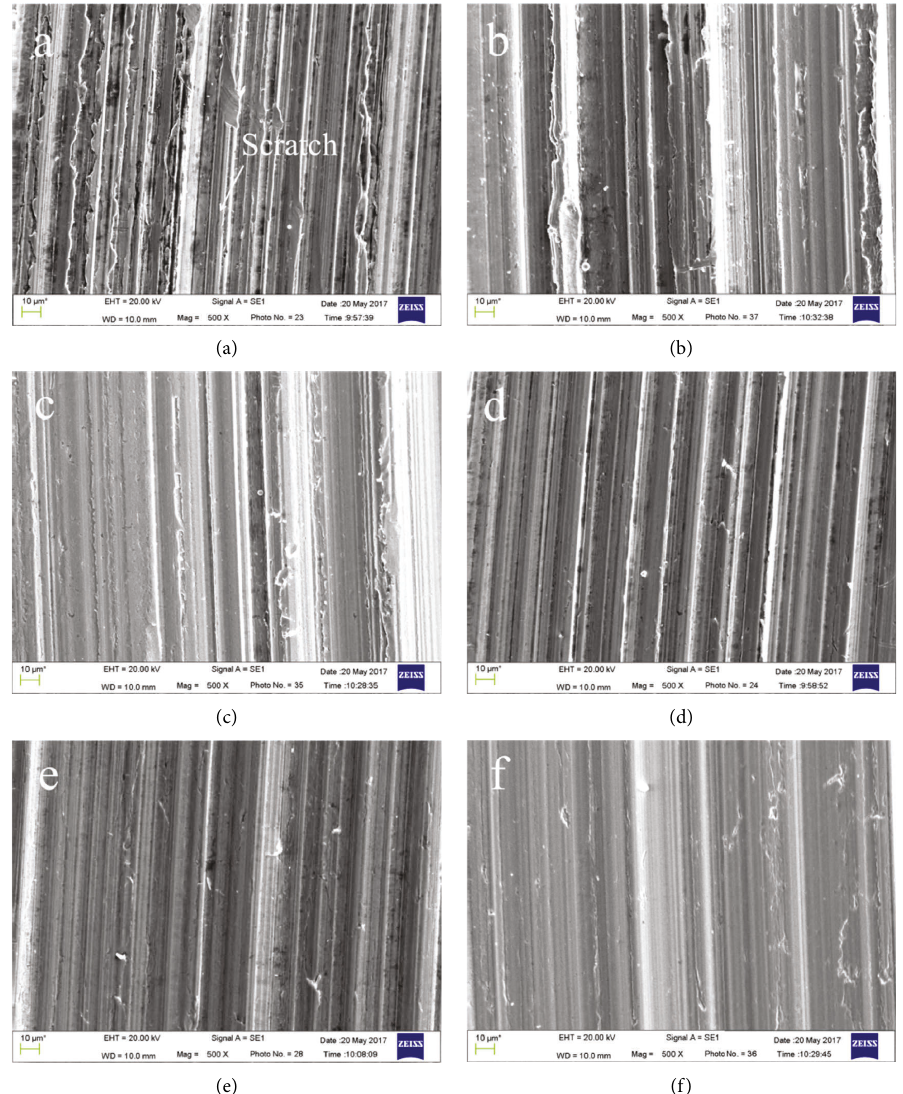
Figure 8: Worn morphologies of the wear scars lubricated with base fluids (a), (b), (c), and nanofluid. (d), (e), and (f) under different loads: (a), (d) 100N, (b), (e) 300 N, (c), (f) 500N (0.1 μ m,